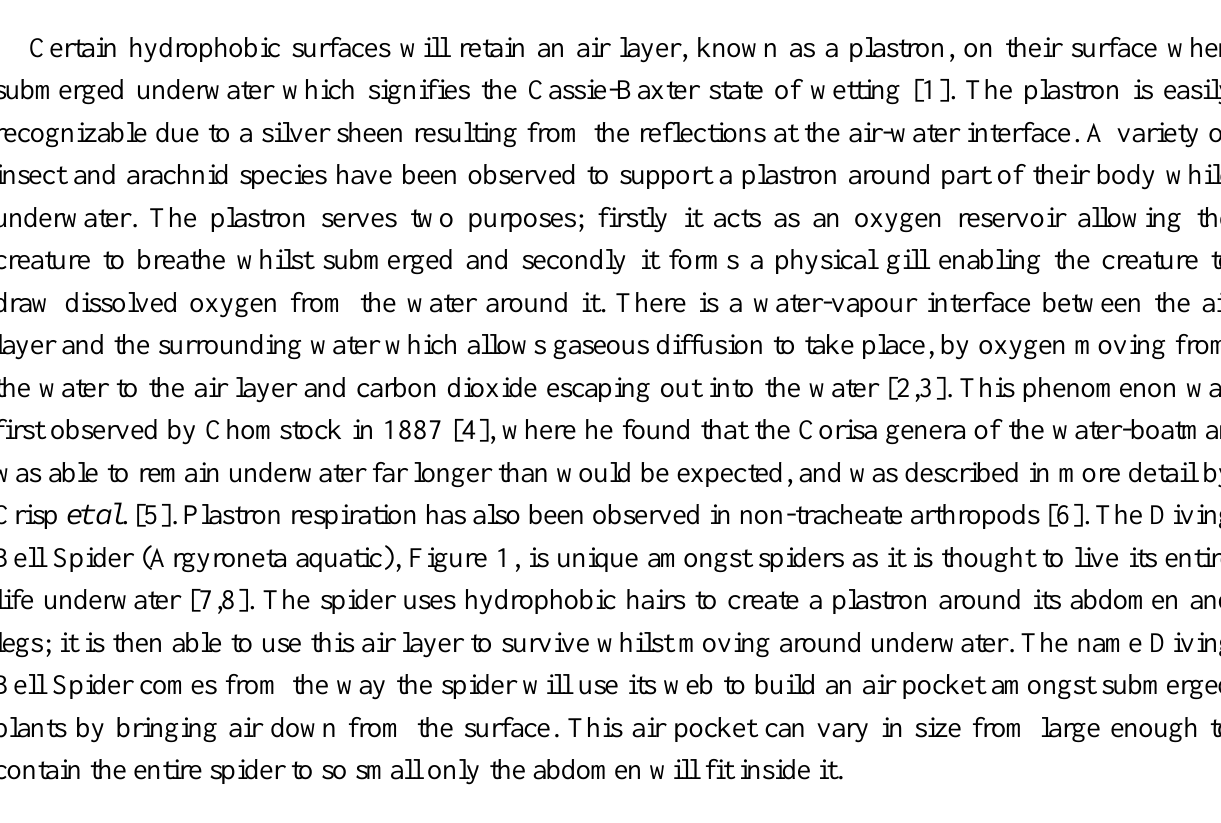
Figure 1. ( a ) Image of submerged diving bell spider reproduced from [8]; ( b ) submerged hydrophobic fabric, both showing the silvery sheen of a